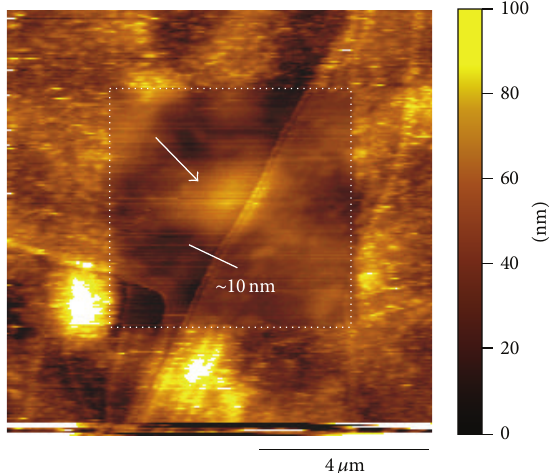
Figure 4: In situ AFM image of an expanded area (10 × 10 𝜇 m 2 ) of the HOPG basal plane surface obtained at 2.9 V after the first cycle of CV. The dotted square shows the area observed after the first cycle in Figure